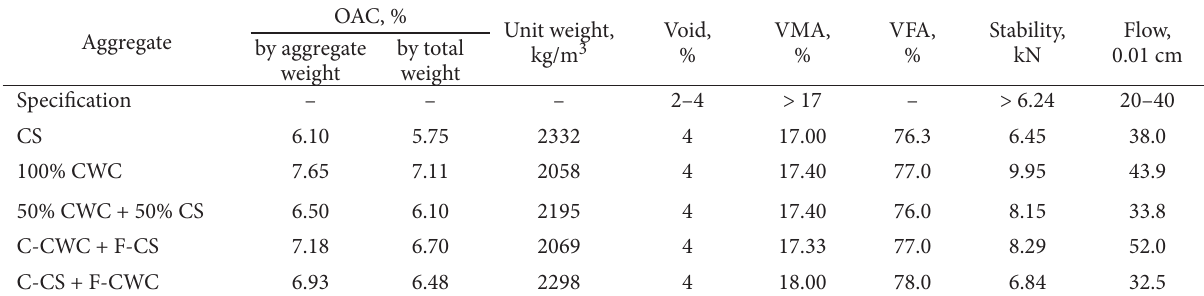
Table 4. SMA mixture properties at optimum asphalt